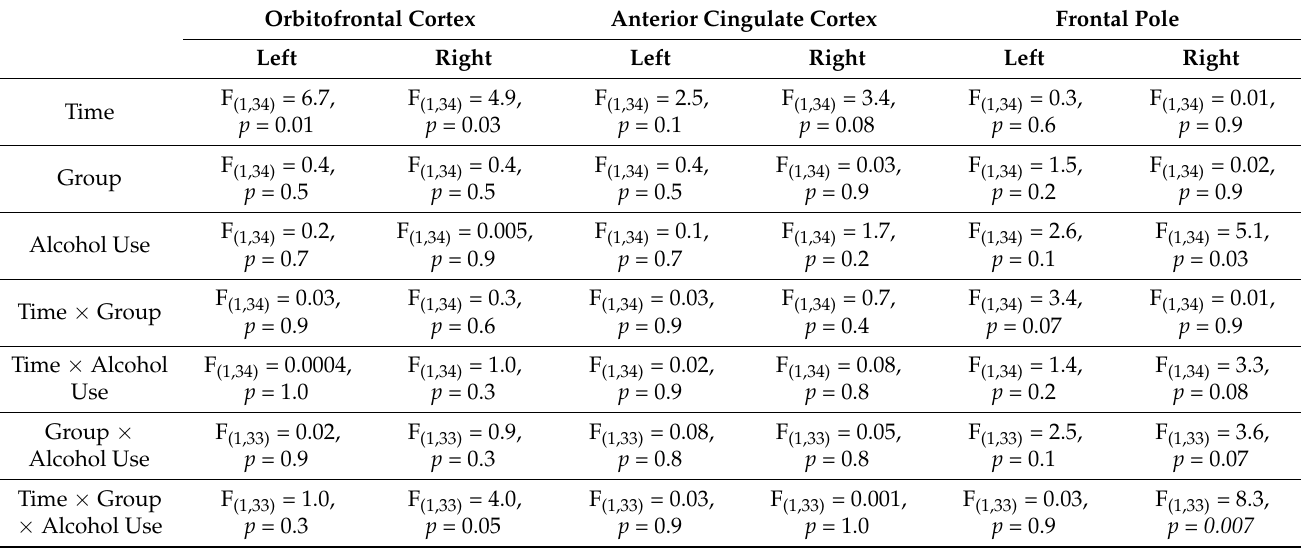
Table 4. Model statistics for prefrontal cortex regions of